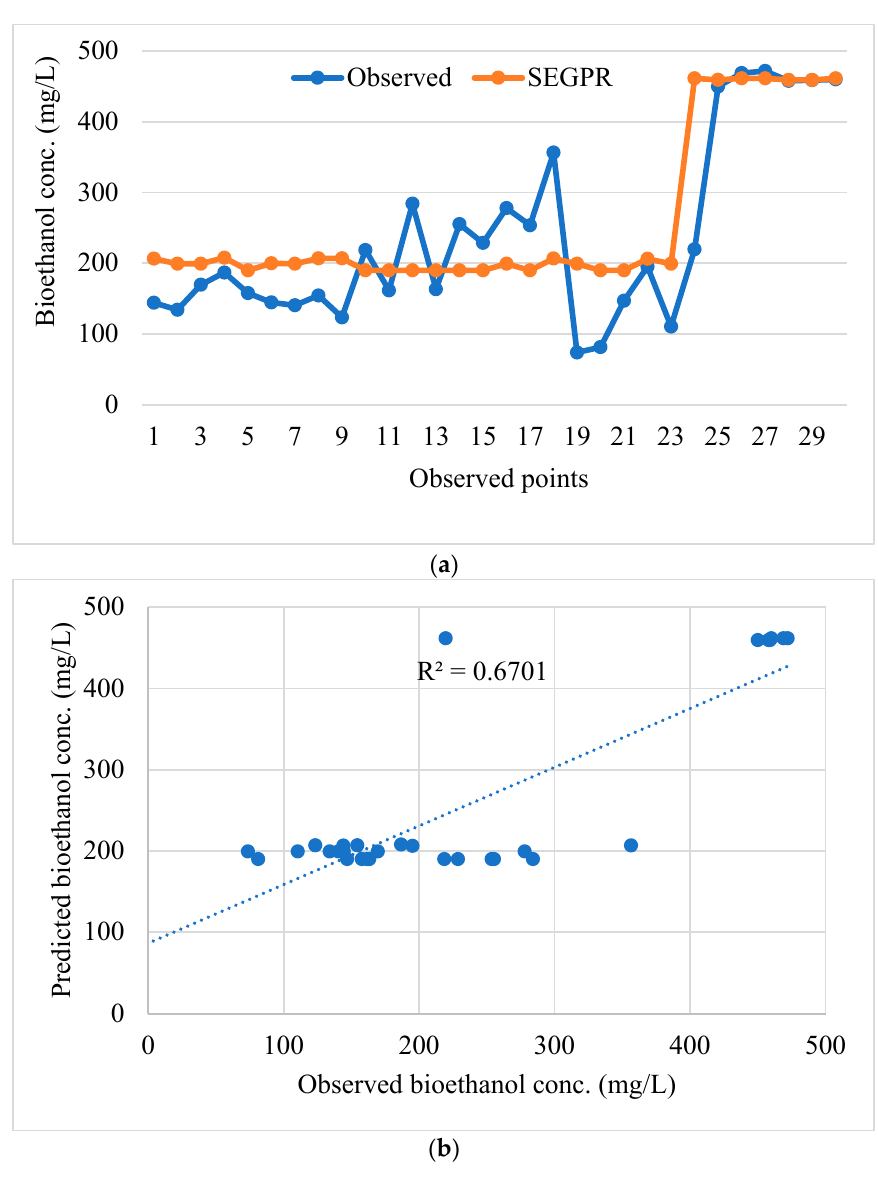
Figure 3. ( a ) Dispersion plots showing the comparison between the actual and the SEGPR predicted bioethanol. ( b ) Regression plots showing the observed and SEGPR predicted bioethanol.